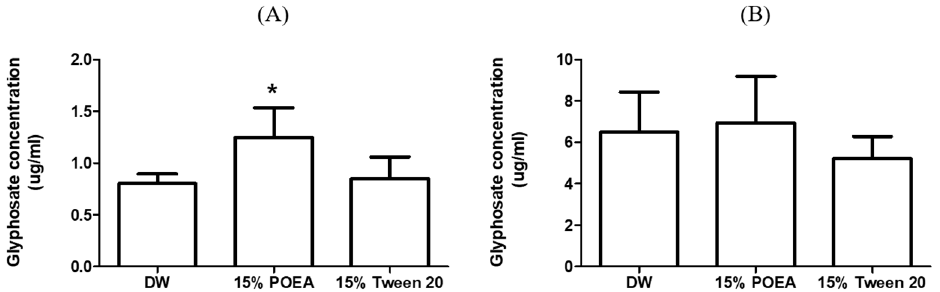
Figure 2. Glyphosate concentration in liver ( A ) and kidney ( B ) of DW, 15% POEA and 15% tween 20 groups for rats ( *: p < 0.05 ) .